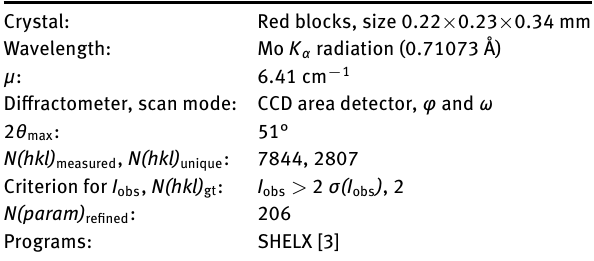
Table 1: Data collection and handling.